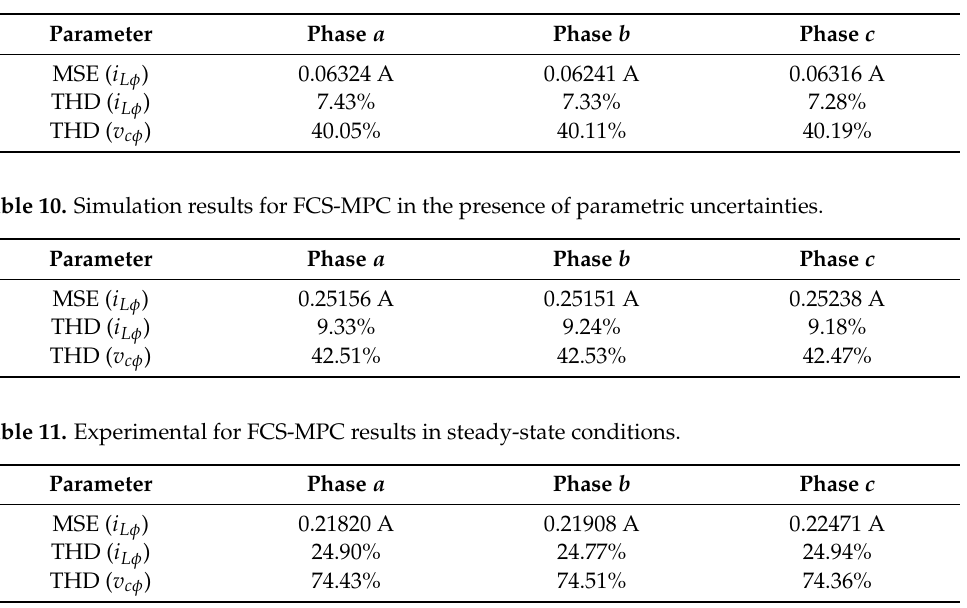
Table 9. Simulation results for FCS-MPC in steady-state conditions.